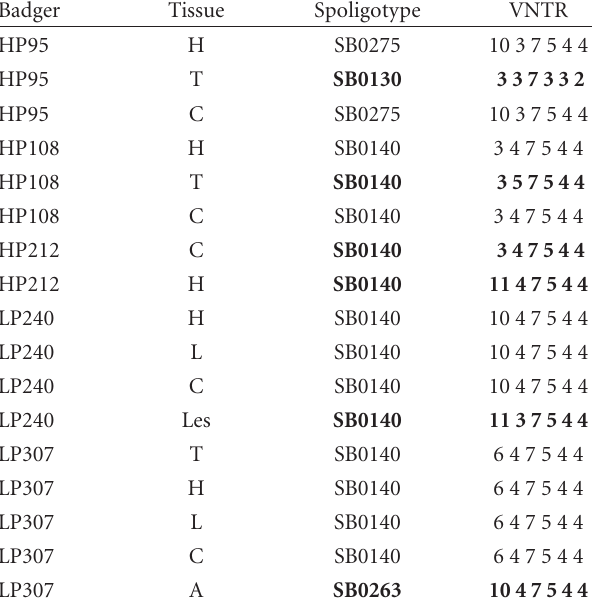
Table 3: Coinfection of badgers with M. bovis strains. Tissues from which M. bovis was isolated: H: head, T: Thorax, C: Carcase, L: Lung, Les: lesion, A: Abdomen. Co-infecting strains are highlighted/ italicised. VNTR loci are listed in order 2163a, 2163b, 2165, 2996, 4052, and